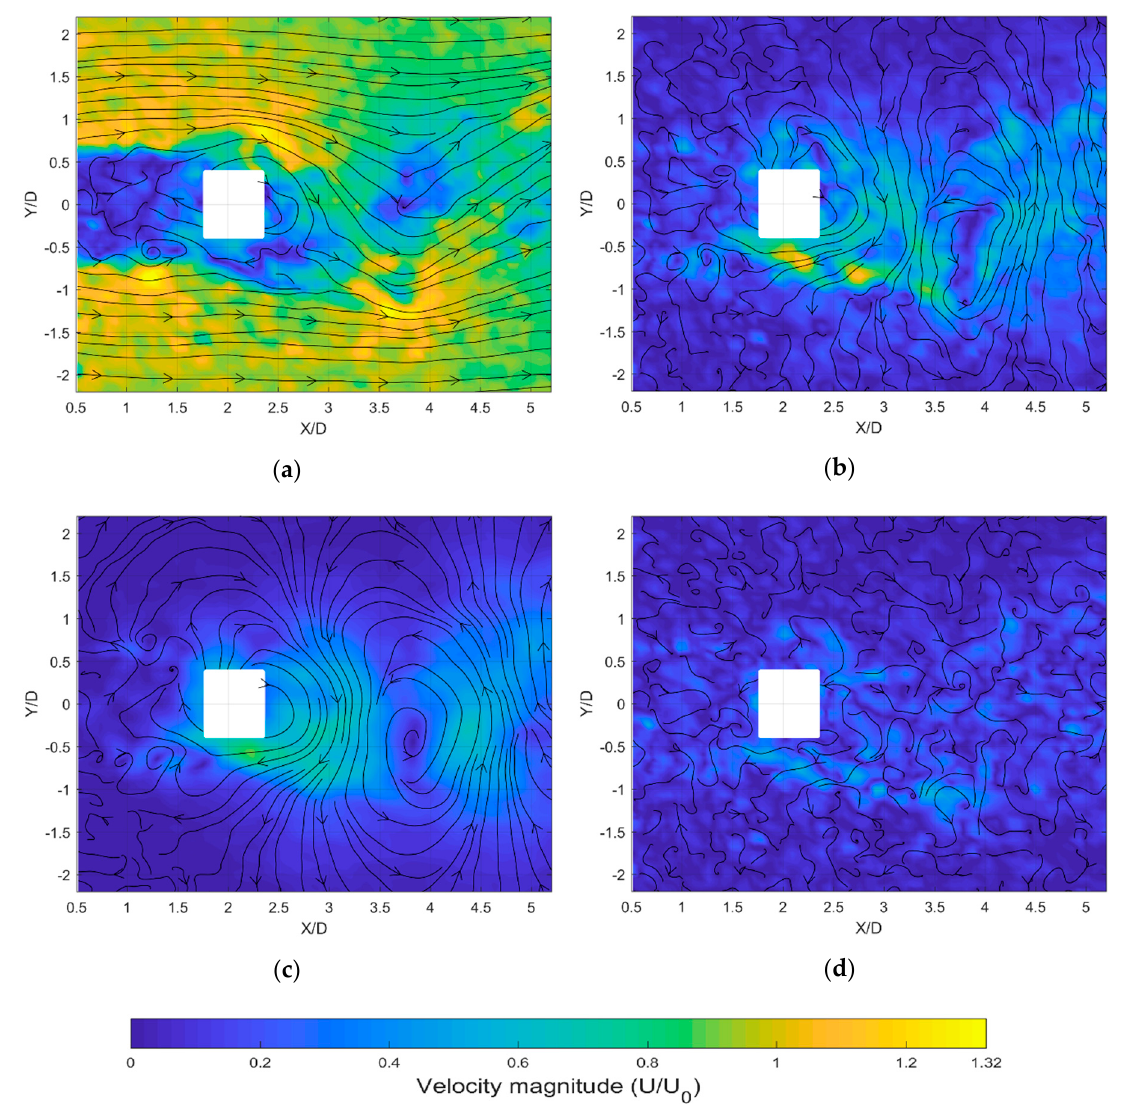
Figure 15. Comparison of fluctuating flow fields for an example flow field. ( a ) Original flow field; ( b ) All fluctuations (Reynolds decomposition); ( c ) Coherent part; ( d ) incoherent part. Colour scale represents velocity magnitude (common scale).